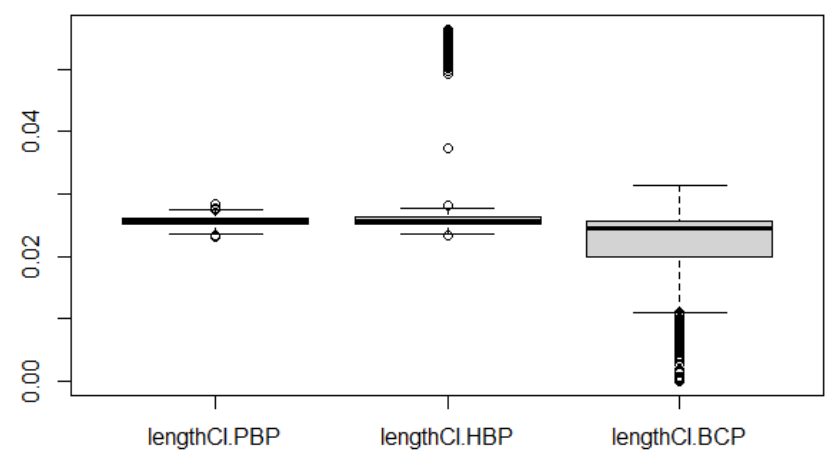
Figure 1. The box plots of bootstrap confidence intervals based on the PBP, HBP and BCP methods for the mixture Weibull distributions.